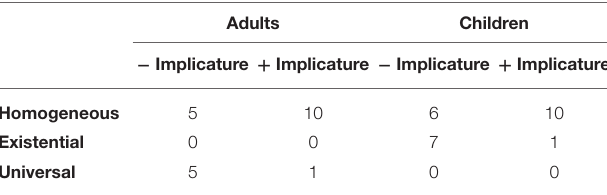
TABLE 1 | Distribution of participants according to their performance on homogeneity and scalar implicature targets. Adults